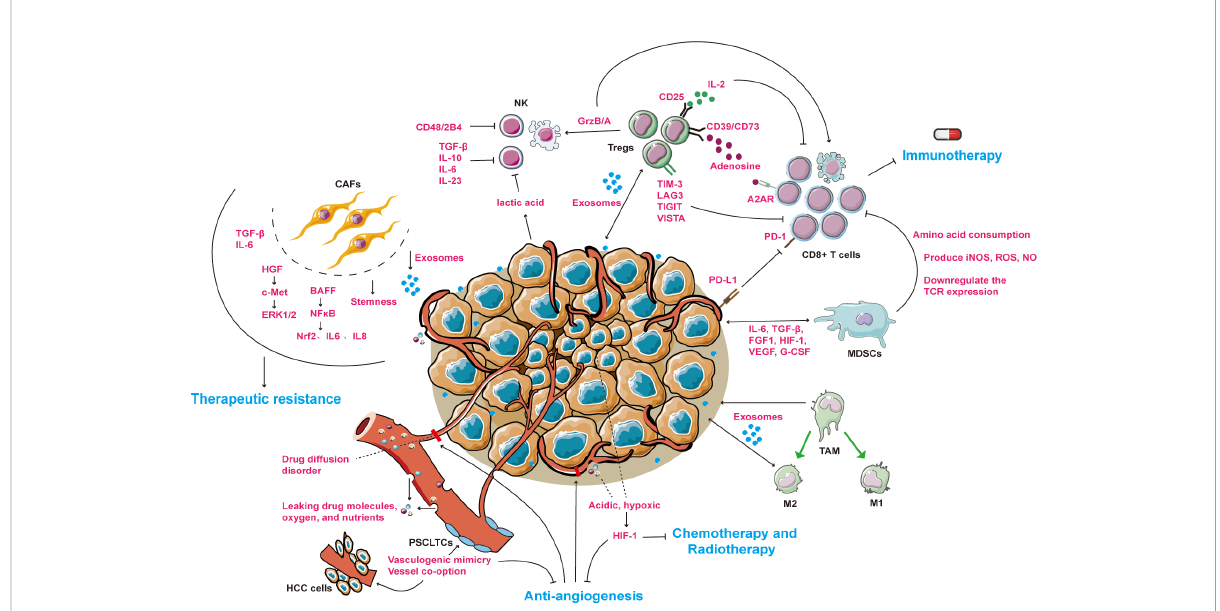
FIGURE 1 An overview of drug resistance mechanisms between tumor microenvironment and HCC cells. The microenvironment of HCC mainly includes cellular components (CAFs, NKs, Tregs, MDSCs, TAMs) and non-cellular components (tumor vasculature system, exosomes and cytokines). Under the combined effect of tumor and microenvironmental components, patients with liver cancer are resistant to immunotherapy, anti- angiogenesis or radiotherapy. ! represents the pointing and promoting effect. ⊥ represents the inhibiting effect. The ↔ representative serves to enhance each other. The blue fonts represent the treatment for HCC patients. The red fonts represent microenvironmental molecules and their mechanisms of action. Black fonts represent cells name. CAFs, cancer associated fi broblasts; NKs, natural killer cells; Tregs, regulatory T cells; MDSCs, myeloid-derived suppressor cells; TAMs, tumor-associated macrophages; M1, tumor suppressor macrophages; M2, tumor-promoting macrophages. PSCLTCs, pluripotent stem cell-like tumor cells. HCC cells, hepatocellular carcinoma